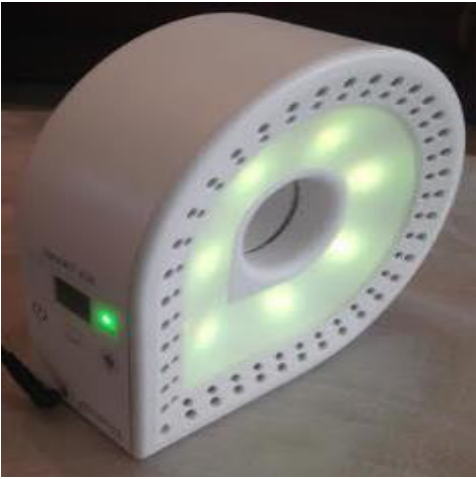
Figure 2. Smart-Air device.